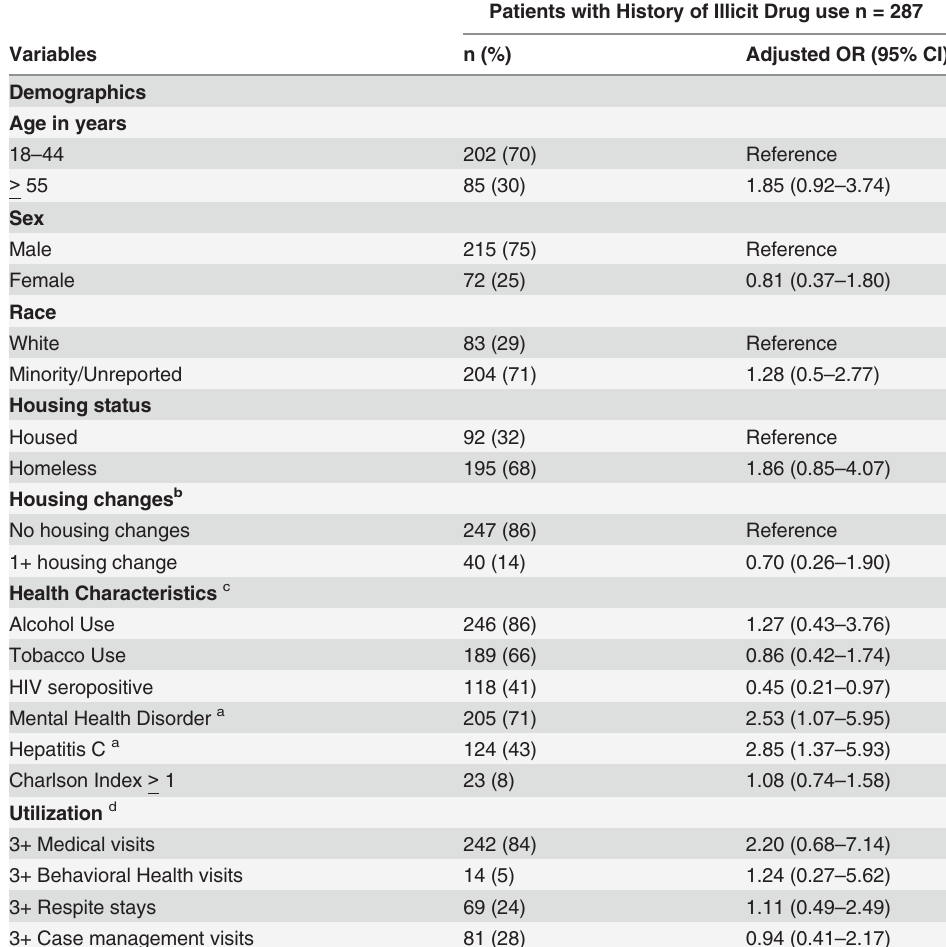
Table 4. Predictors of Frequent Emergency Room Visits in Patients with History of Illicit Drug Use. Patients with History of Illicit Drug use n = 287 Variables n (%) Adjusted OR (95%